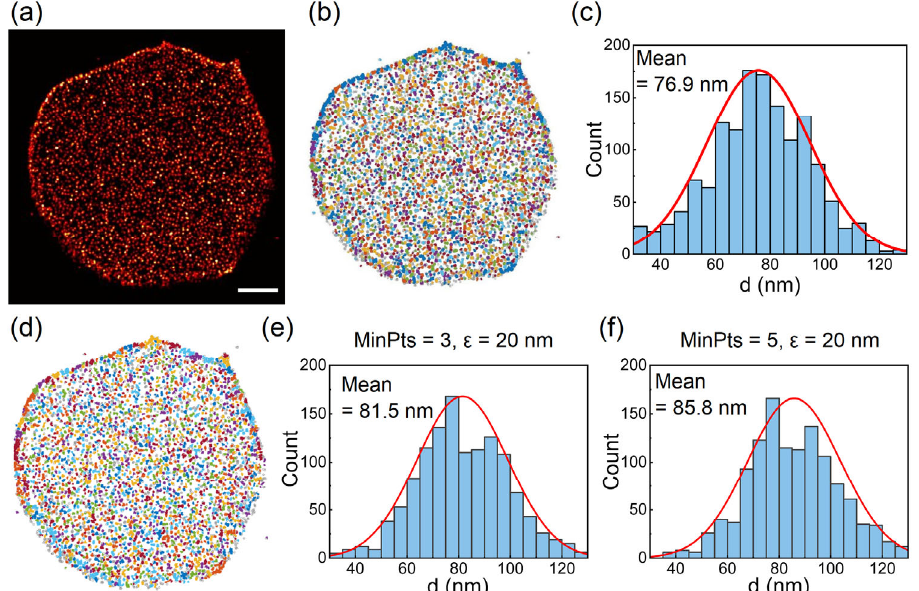
Figure 9. Comparison of FACAM and DBSCAN in determining the junction-to-junction distance in the erythrocyte cytoskeleton. ( a ) A reconstructed super-resolution image showing the distribution of β -spectrin in the erythrocyte cytoskeleton. Scale bar: 1 µm. ( b ) Visualization of the clustering results from FACAM in ( a ). A total of 1459 clusters were obtained. ( c ) The distribution of nearest neighbor distance between clusters from FACAM. R 2 = 0.99. ( d ) Visualization of the clustering results from DBSCAN in ( a ). A total of 1468 clusters were obtained (MinPts = 3, ε = 20 nm). ( e ) The distribution of nearest neighbor distances between clusters from DBSCAN (MinPts = 3, ε = 20 nm). R 2 = 0.96. ( f ) The distribution of nearest neighbor distances between clusters from DBSCAN (MinPts = 5, ε = 20 nm). R 2 = 0.95.